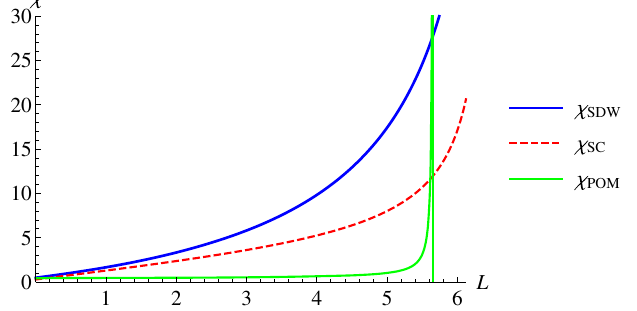
FIG. 5. The flow of the susceptibilities for repulsive bare interaction in the orbital channel. We first solve the RG equations for the running couplings, and then solve RG equations for vertices and susceptibilities in SDW, SC ( s þ − ), and d -wave ( B 1 ) Pomeranchuk channels using the running couplings as inputs. We use J ¼ 0 . 02 , U ¼ 4 . 1 J , U 0 ¼ U − 2 J , J 0 ¼ J